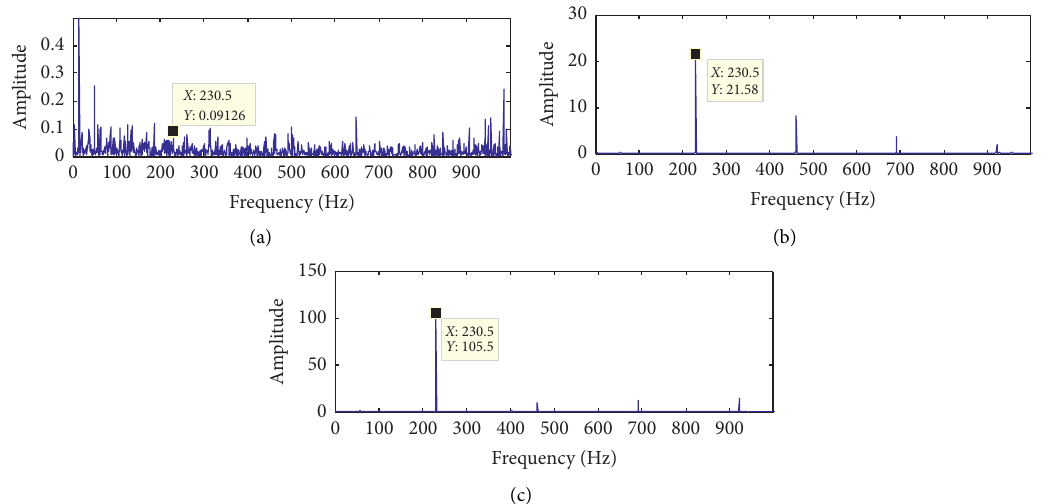
Figure 10: The envelope spectrums in the test for bearing 2# of testing 2 at different operating moments: (a) the trigger value of the proposed method at point 502, (b) the trigger value of the compared method at point 651, and (c) the breakdown value of the whole-life bearing at point 960.